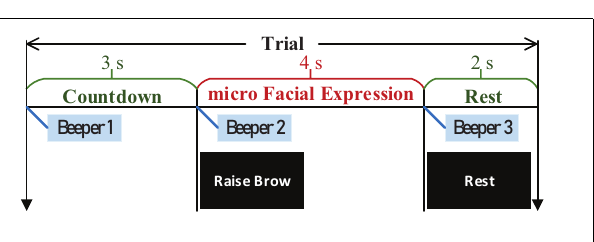
FIGURE 11 | Timing diagram of each